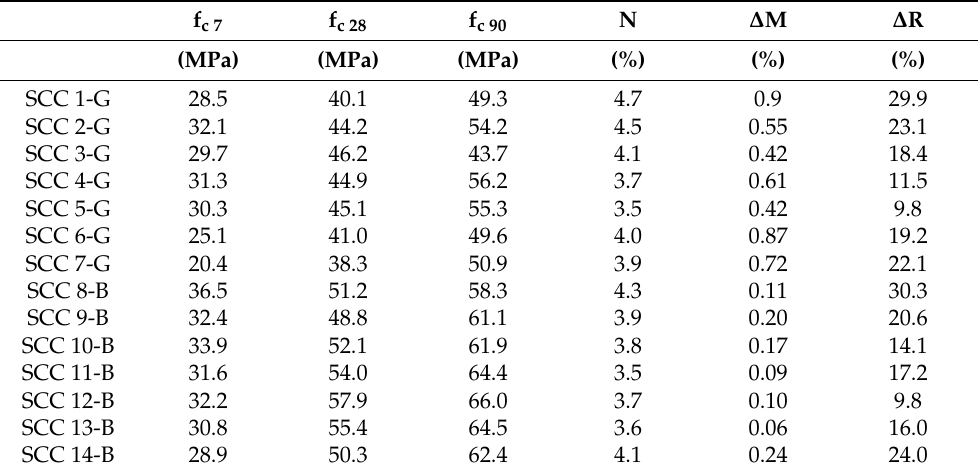
Table 16. Juxtaposition of the results of analyses of the rheological features of concrete mixes.